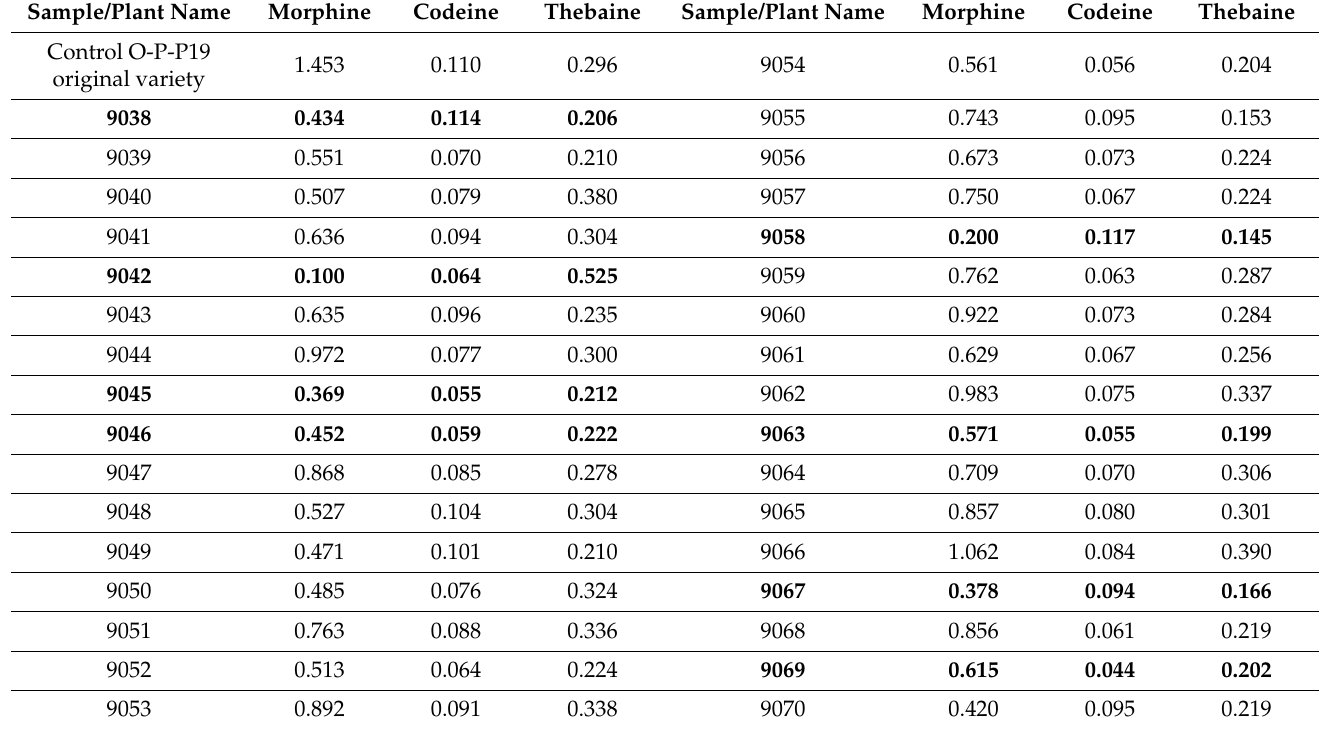
Table 3. Content of main alkaloids in selected M3 plants assessed by HPLC method. Numbers express the percent of the total sample volume. Genotypes selected for RT-qPCR analysis are marked in